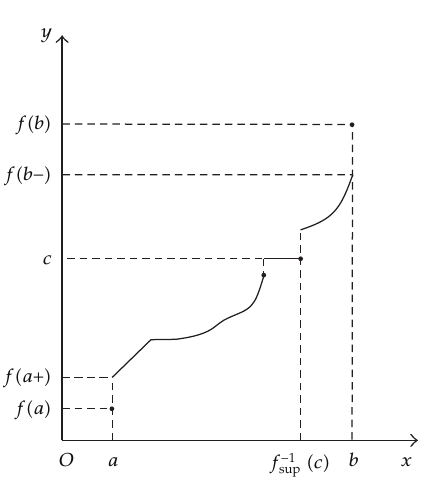
Figure 1: The geometry of Young’s inequality when f (cid:5) a (cid:4) ≤ c ≤ f (cid:5) b − (cid:4)